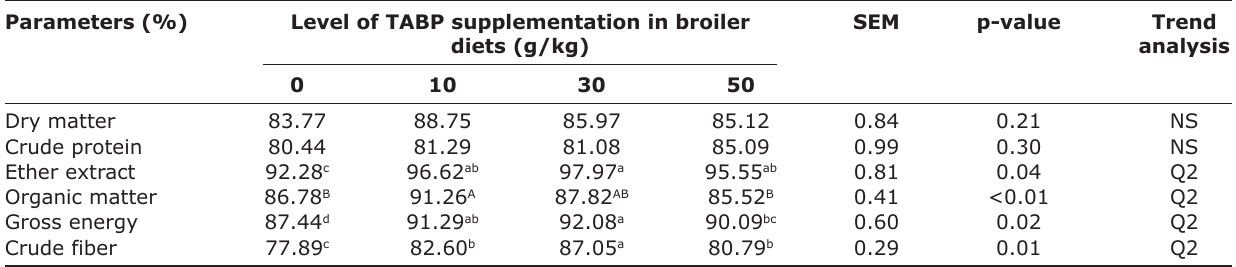
Table-3: Effects of TABP supplementation in broiler diets on apparent nutrient